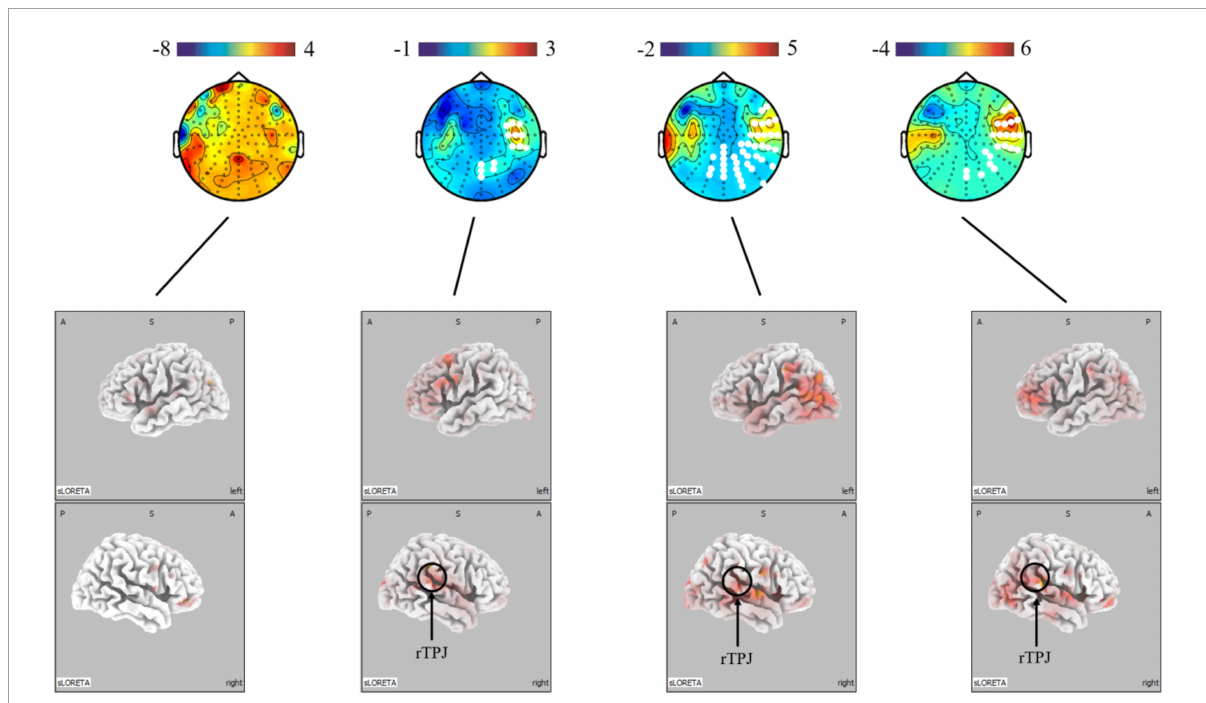
FIGURE5 Topographical maps for EEG power and LORETA probabilistic map showing cortical activation and a significant difference between micro-expression under positive emotion and negative emotion (positive emotion minus negative emotion). Red colors represent a greater activation, blue colors represent a less activation. The white dots are the electrode points with significant